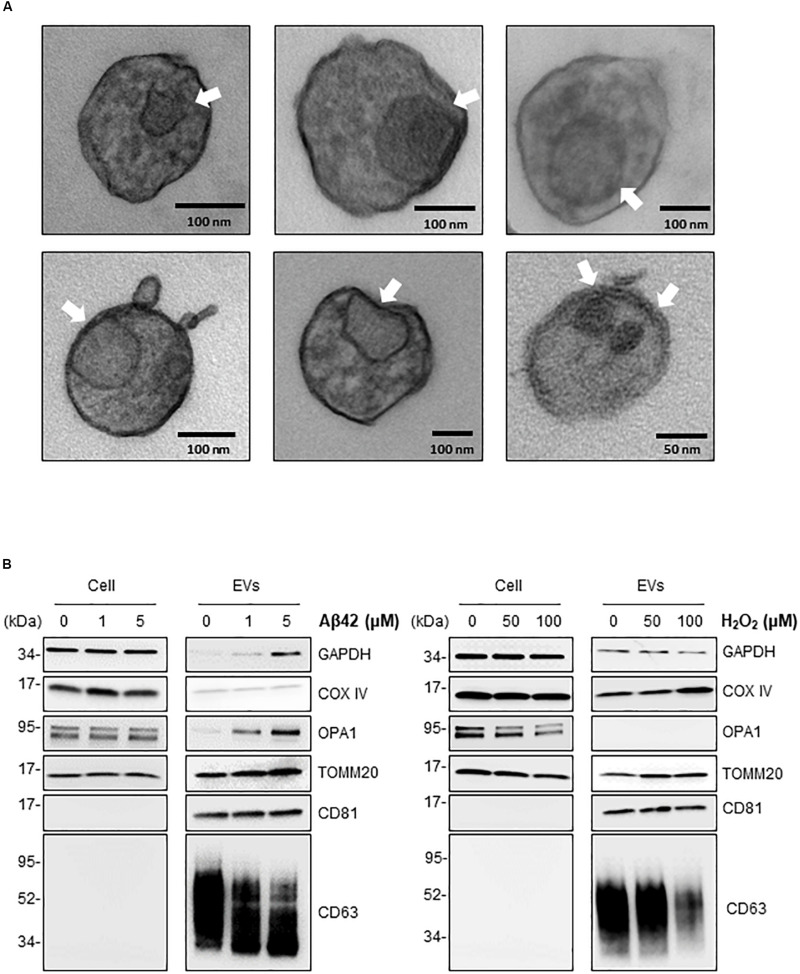
Treatment of astrocytoma with Aβ42 and H2O2 increases the presence of inclusions and mitochondrial proteins in EVs. (A) EVs were isolated from astrocytoma cells treated with 1 μM Aβ42 for 3 days. Representative transmission electron microscopy (TEM) images showing inclusions of structures (arrows) consistent with mitochondria fragments. Black bars, size scale. (B) Western blot analysis of COXIV, OPA1, TOMM20, GAPDH, CD81, and CD63 using whole-cell lysates (‘Cell’) and EVs obtained from astrocytes after the indicated treatments.